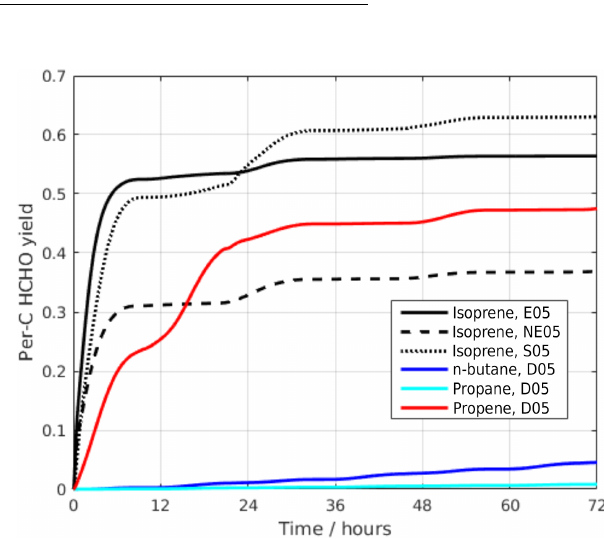
Figure 3. Time-dependent cumulative HCHO yield (per-C) pro- duced from isoprene in three contrasting photochemical environ- ments, and from propene, propane, and n -butane in an urban pho- tochemical environments based on Delhi. Calculations are denoted by an alphanumeric code that is explained in Table